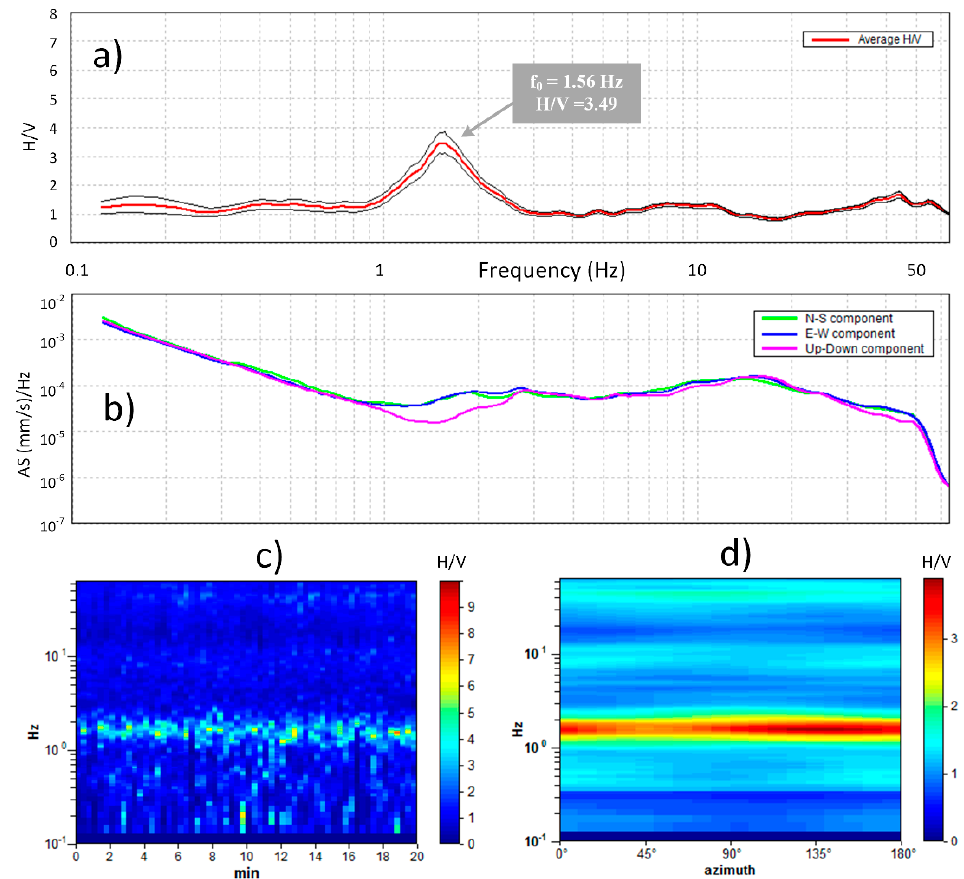
Figure 4. ( a ) Example of HVSR curve at measurement location 42. The x-axis represents frequency (Hz). The y-axis represents HVSR amplitude. The average HVSR plot is represented by a thick red line. Black thin lines indicate the 95% confidence interval of the HVSR. ( b ) Single component amplitude spectra. The x-axis represents frequency (Hz). The y-axis represents amplitude of single component spectra. The spectral signature of the H/V peaks is found to be 'eye-shaped' within the horizontal to vertical spectra. ( c ) H/V frequency-time history plot. ( d ) Directional HVSR plot. The HVSR function (represented on the z-axis by the colour scale) shows a peak around the fundamental frequency (y-axis) and azimuth (x-axis).